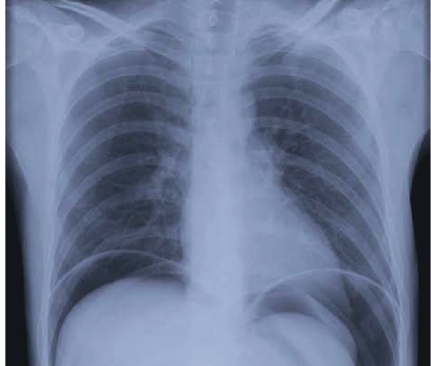
Figure 1: Chest X-ray showing gas under diaphragm.